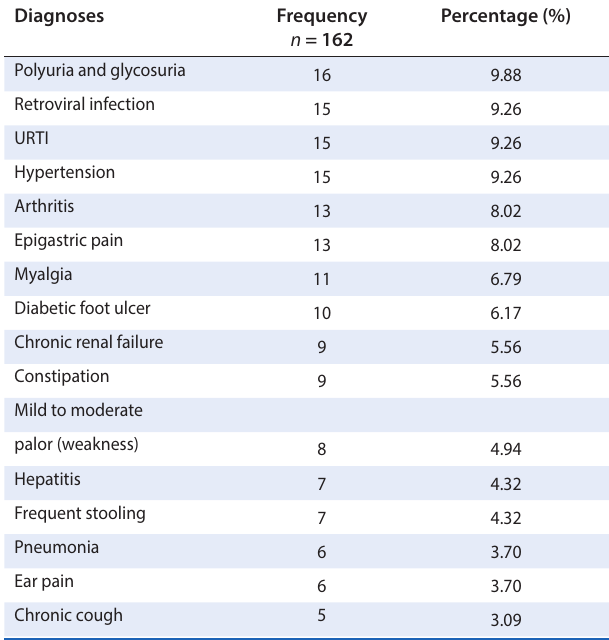
Table 3: Clinical presentation of inappropriate cases by ICPC rubrics in AED Diagnoses